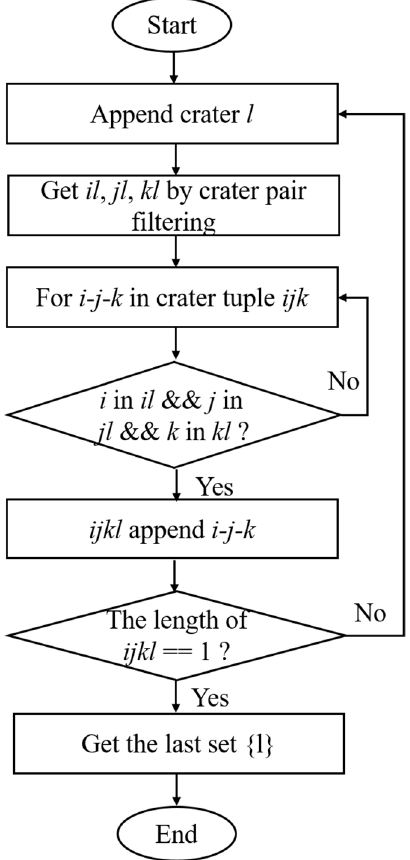
Figure 8. The flow chart of iterative pyramid-matching method.